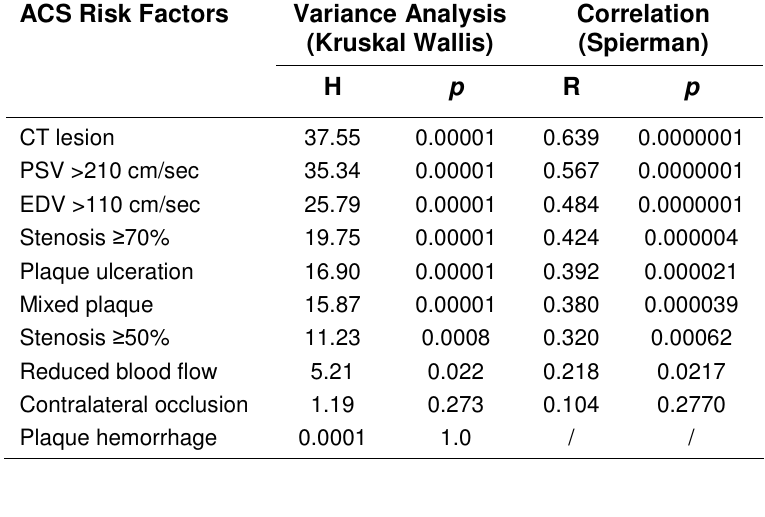
Correlations of Local Risk Factors and Neurological Events and Deaths in ACS Variance